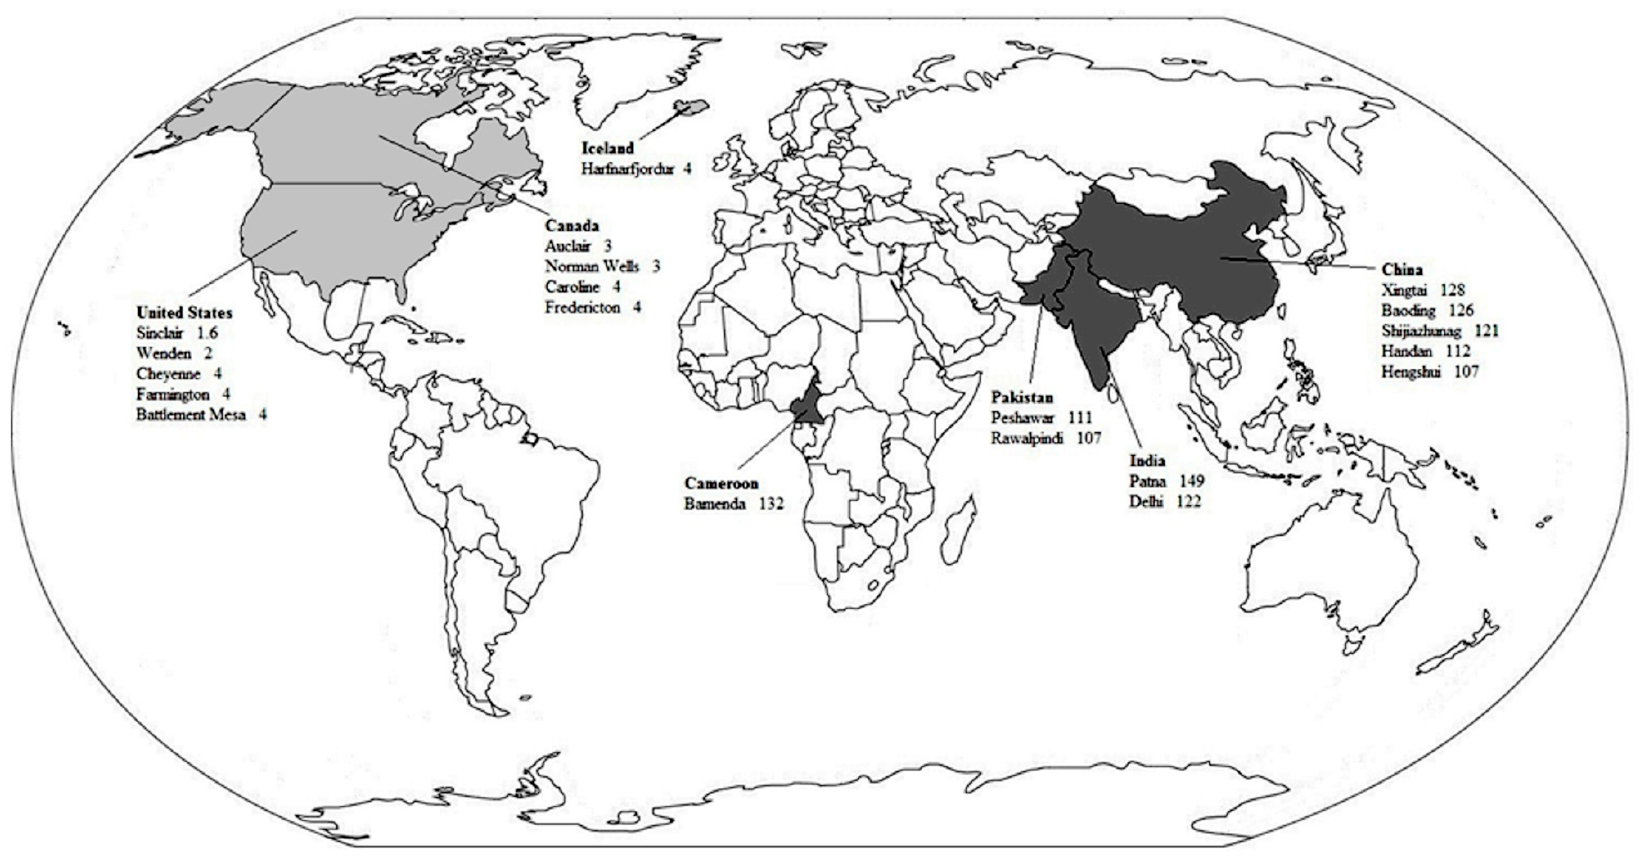
Figure 2. PM 2.5 annual means by the 10 cleanest and 10 dirtiest cities. Countries with the cleanest cities are in light gray. Countries with the dirtiest cities are in dark gray. Adapted from the WHO data on the average annual concentration of PM 2.5 per city (data from http://www.who.int/phe/health_topics/outdoorair/databases/en/) [14].